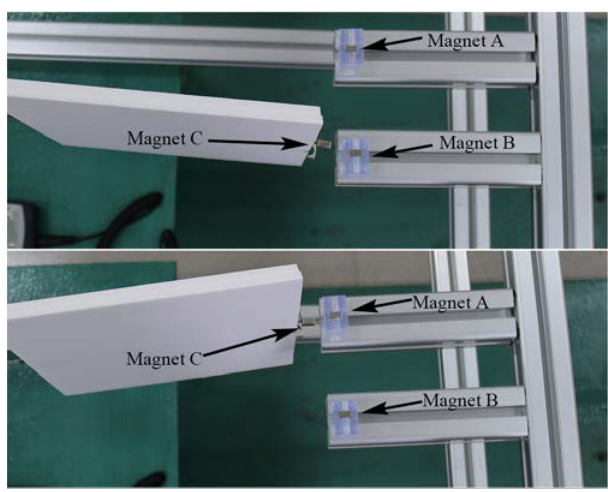
Figure 5. Two static stable positions of the DFEH.